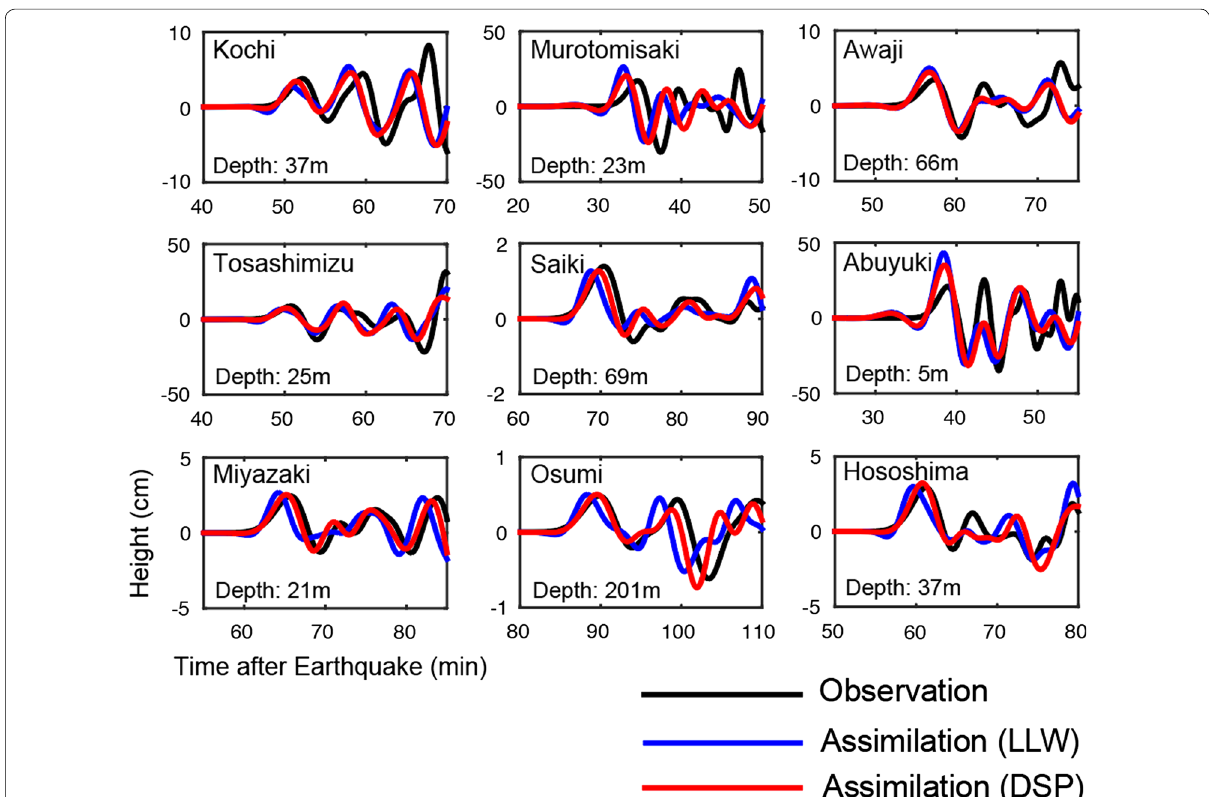
Fig. 3 Simulated waveforms (black lines) and waveforms forecasted by data assimilation at nine near-shore PoIs. The water depth of each PoI is provided. The forecasted waveforms are calculated by GFTDA using the LLW model (blue lines) and the linear DSP model (red lines). The time window of data assimilation is 20